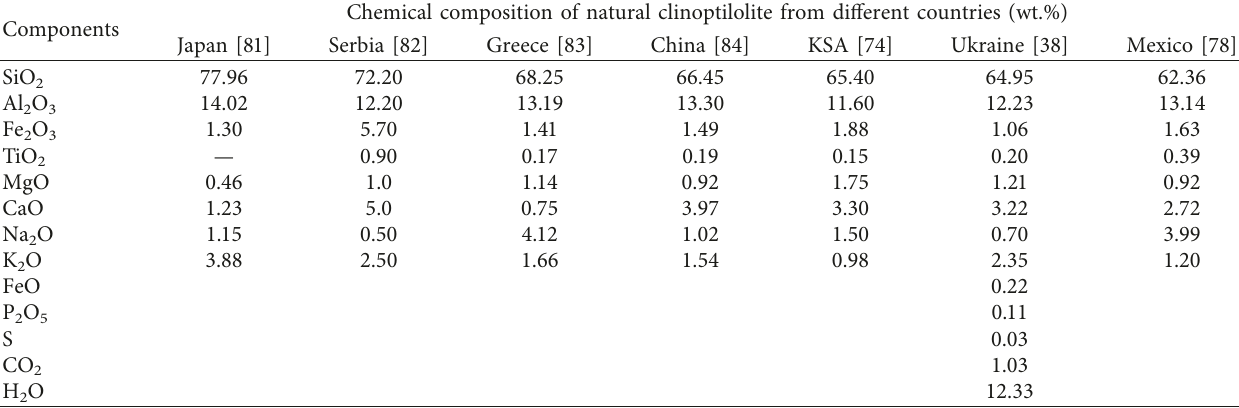
Table 1: Average of chemical composition (wt.%) of natural clinoptilolite from various countries.